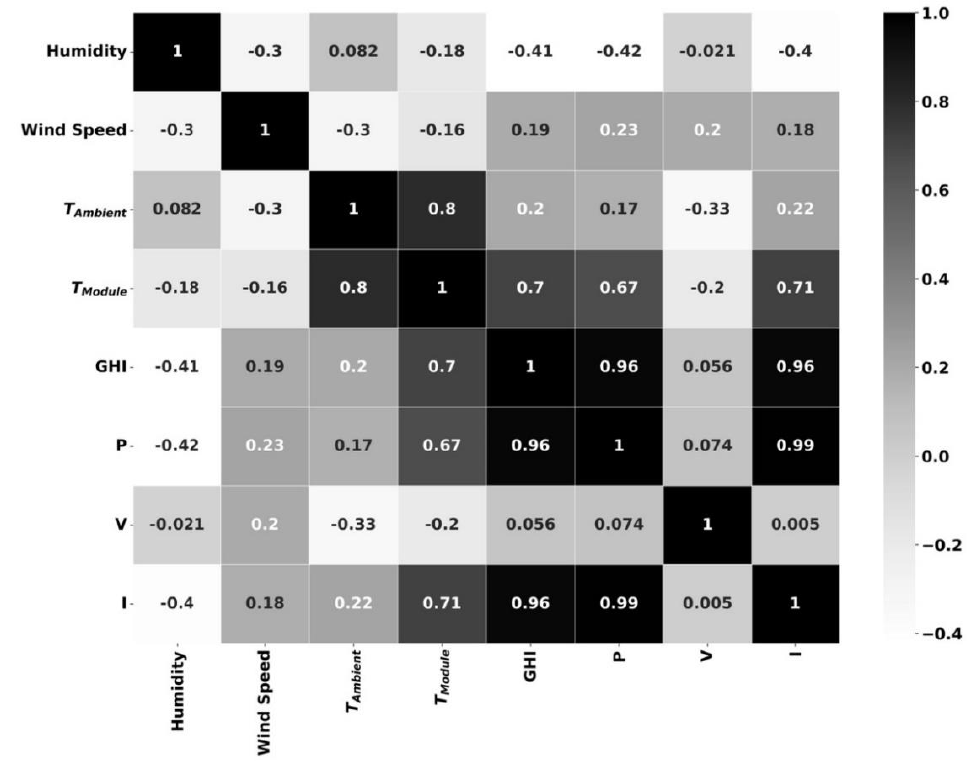
Figure 7. Confusion matrix of pre-processed data.